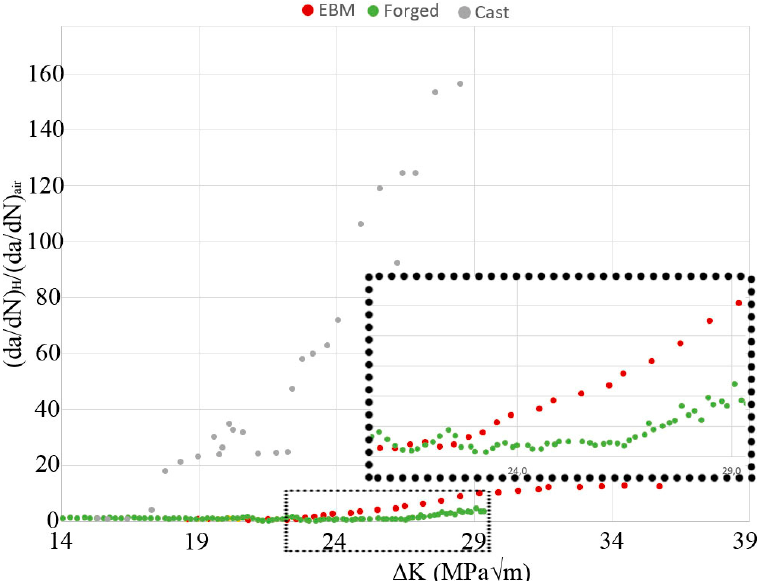
Figure 14. FCG data for EBM, forged [26], and cast [28] Ti-6Al-4V. The y-axis shows the crack propagation rate in hydrogen divided by the crack propagation rate for air, the x-axis shows ∆ K. The dashed box is a magnified image to more clearly show the critical points in crack growth rate for the EBM and forged material.